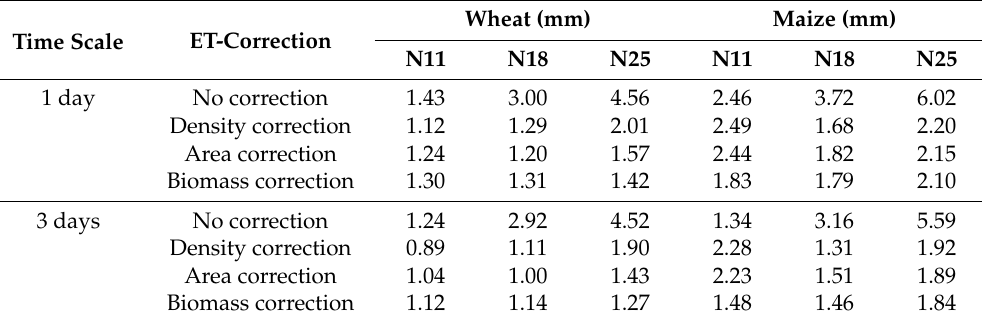
Table 3. The root mean square errors (RMSEs) of the uncorrected and corrected daily ET values of the pots compared with those of the